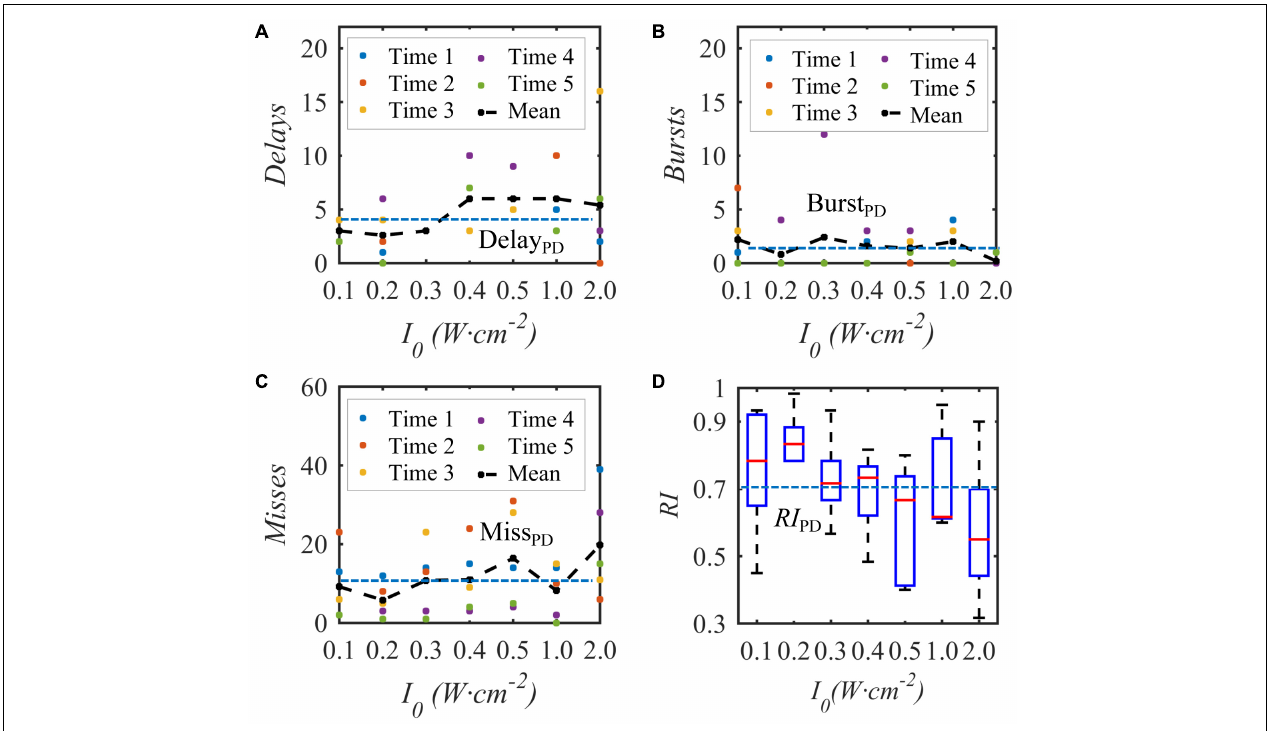
FIGURE 9 | The influence of the input sound intensity of the biased ultrasound TMAS on the abnormal discharge of the Th nerve nucleus in the BG-Th neural network. (A–C) Number of delay, burst and missed firing, (D) RI from Th. The points and curves are the average of single and five times after stimulation, the dashed line is the average of five times in the PD state, ( f = 0.5 MHz, f s = 10 Hz, T 1 /T s = 50%, B = 0.3 T).